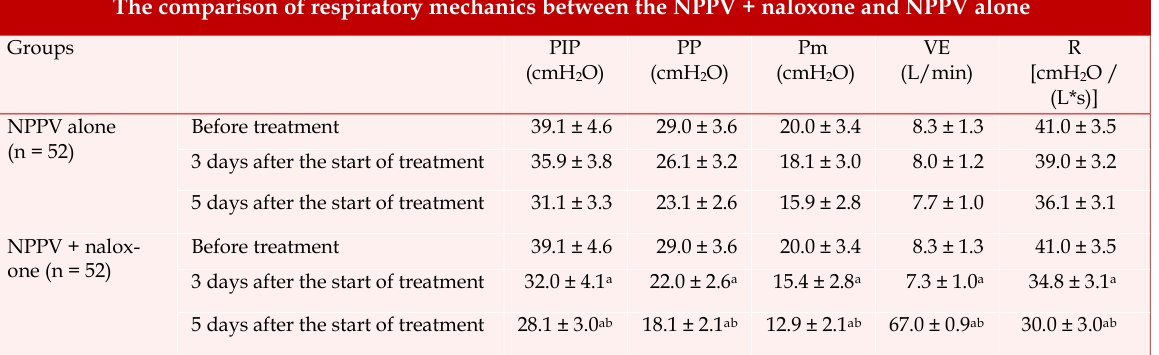
The comparison of respiratory mechanics between the NPPV + naloxone and NPPV alone Groups